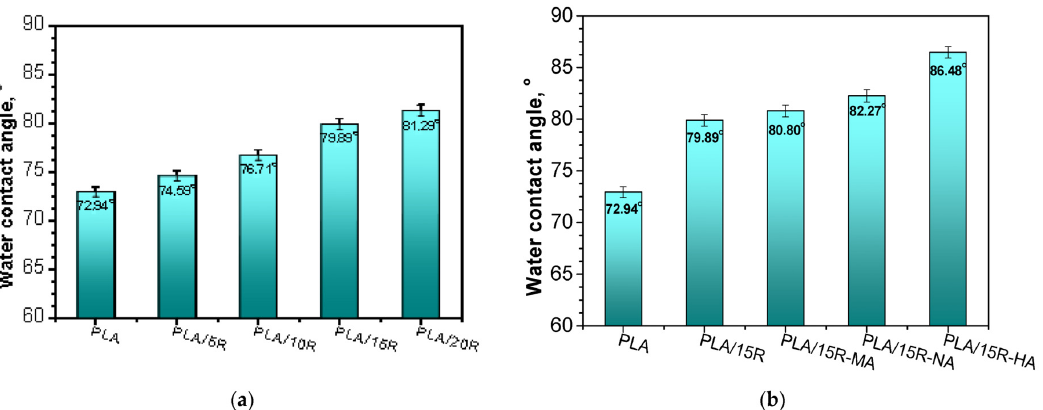
Figure 4. Water contact angle of ( a ) neat PLA and PLA-based materials containing pure castor oil; ( b ) PLA-based materials containing anhydrides modified castor